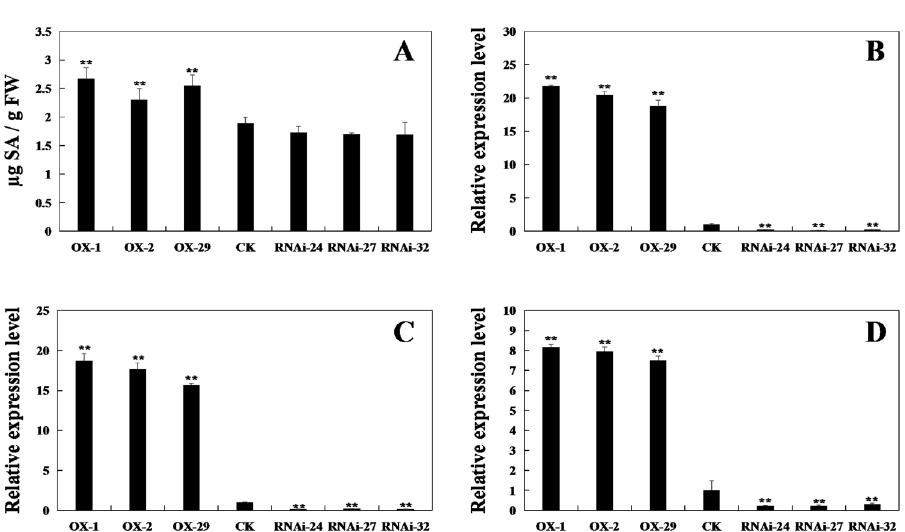
Figure 8. The content of SA and expression analysis of GmNPR1 , GmPR1 and GmPR5 in transgenic and non-transgenic soybeans. The content of SA in leaves of transgenic and non-transgenic soybeans. ( B ) The relative transcript abundance of GmNPR1 (NM_001251745) in transgenic and non-transgenic soybeans. ( C ) The relative transcript abundance of GmPR1 (AF136636) in transgenic and non-transgenic soybeans. ( D ) The relative transcript abundance of GmPR5 (M21297) in transgenic and non-transgenic soybeans. The amplification of the soybean Actin ( GmActin4 ) gene was used as an internal control to normalize all the data. Three technical replicates were averaged and statistically analyzed using Student’s t-test ( ** P < 0.01). Bars indicate the standard error of the mean. The data are the means ± SD from three independent experiments. Asterisks indicate significant differences as determined by Student’s t-test (P <